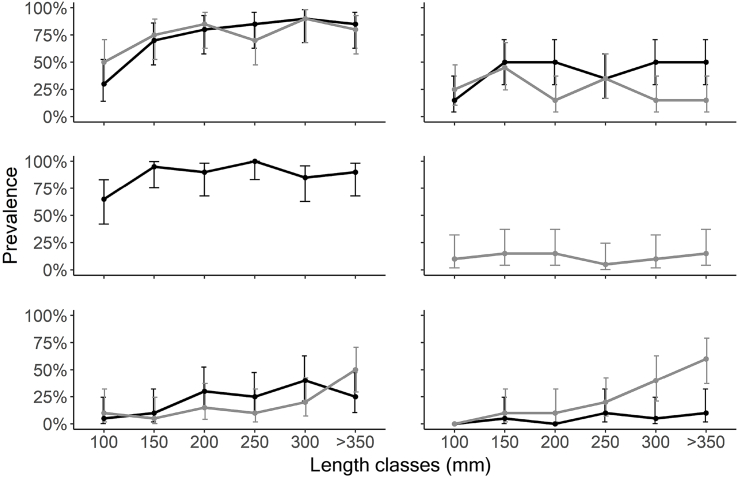
Prevalence of intestinal parasites in Arctic charr (black) and brown trout (grey) throughout their ontogenesis with 95% confidence intervals.